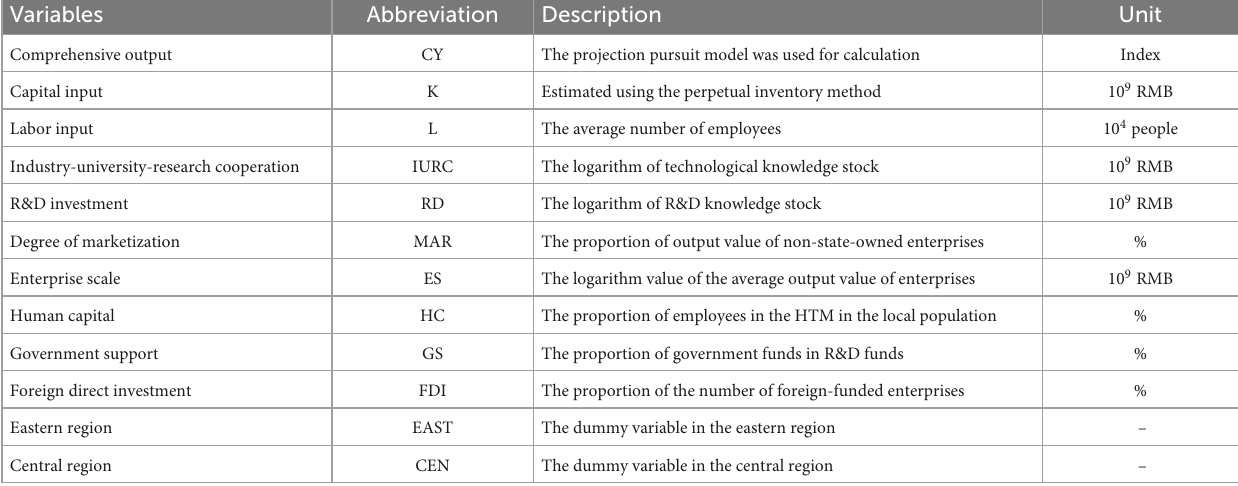
TABLE 1 The description of